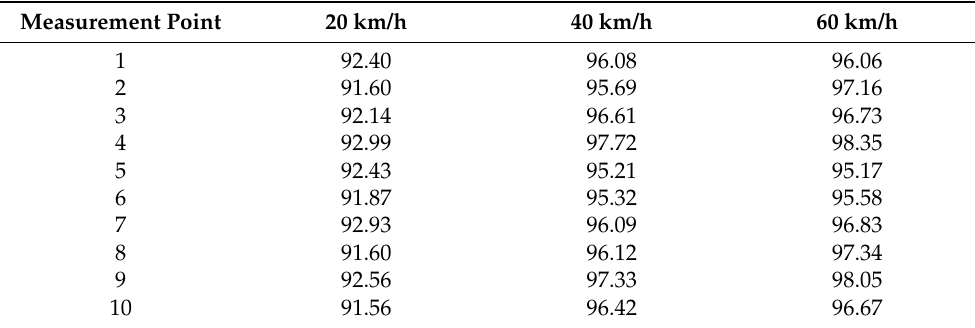
Table 1. Equivalent continuous A-weighting sound pressure levels of different measurement points at the three speeds (unit: